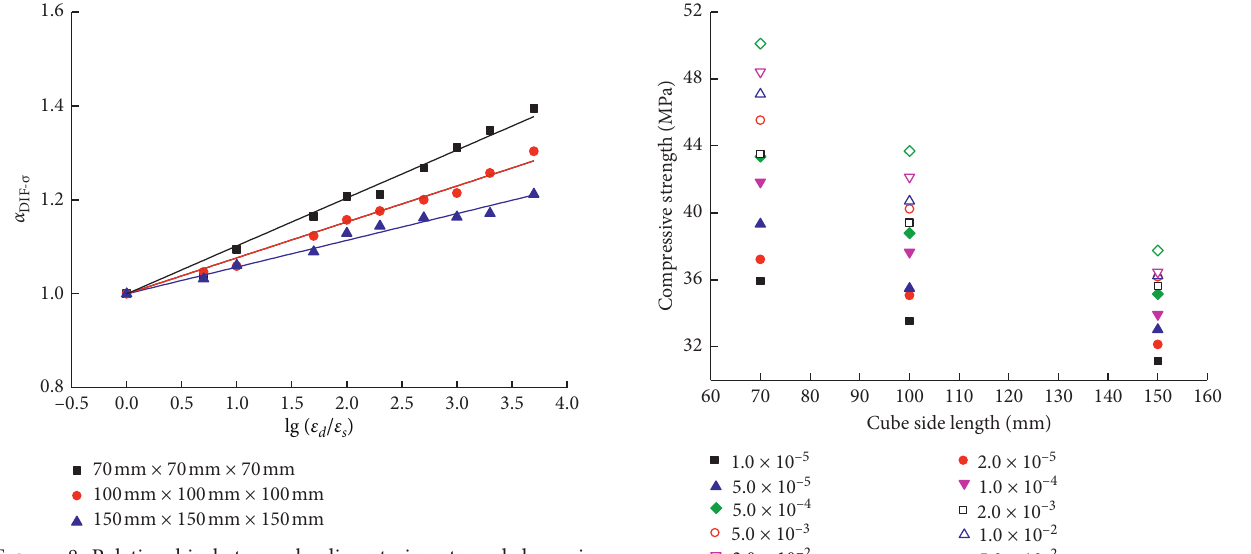
Figure 8: Relationship between loading strain rate and dynamic improvement